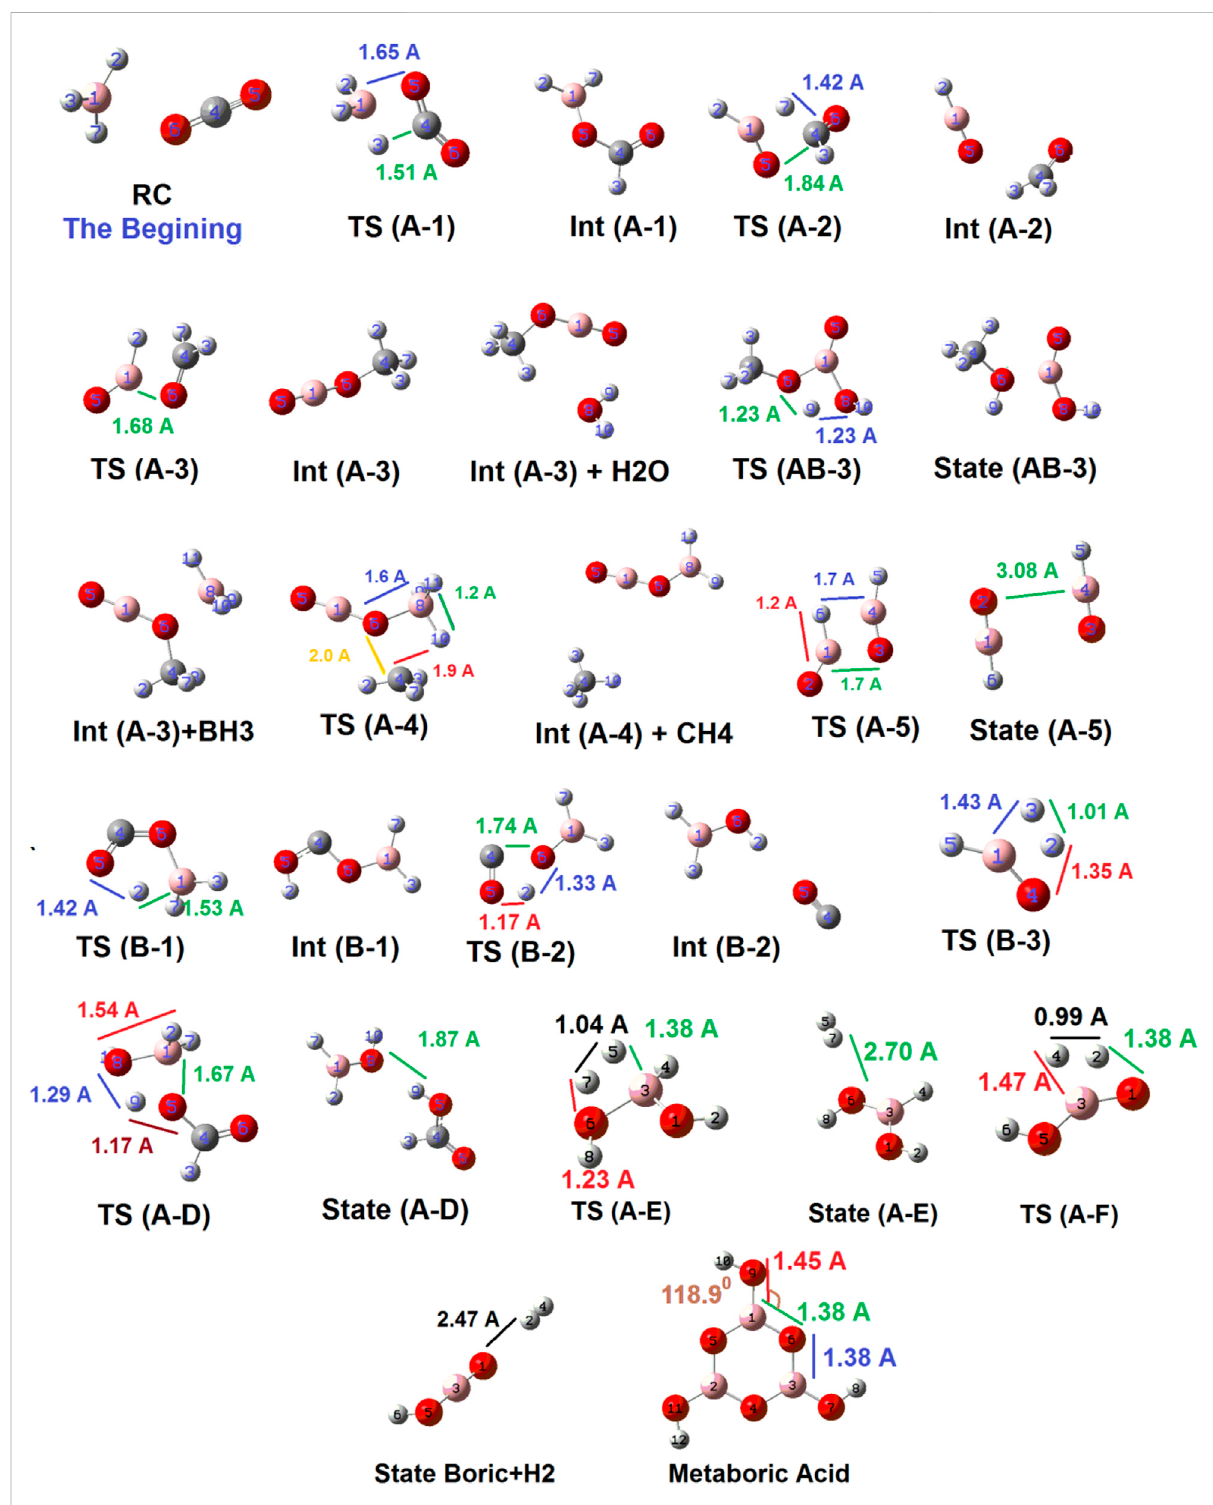
FIGURE 4 Geometrical structures of all detected species which emerge during the reaction coordinate optimized at B3LYP/6-311++G (d,p) level of